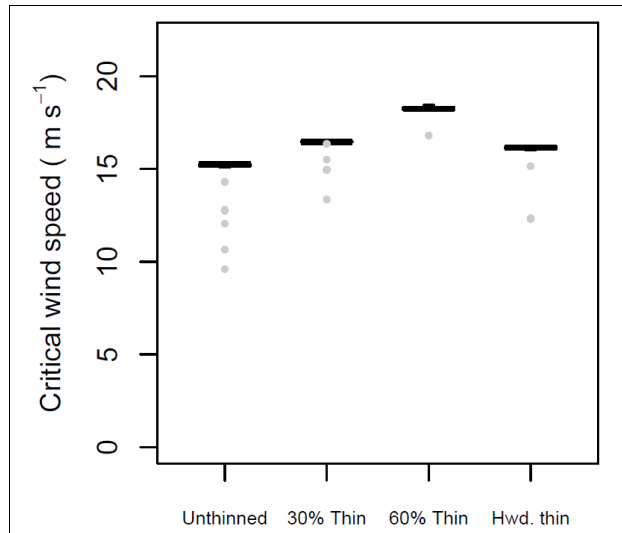
FIGURE 8 | Mean, 25 and 75% percentiles, 1.5 × interquartile range (whiskers), and outliers of critical wind speed (CWS) in m s − 1 , for intact forest and three silvicultural treatments. A 30% thin removed smallest trees up to 30% of basal area. A 60% thin removed smallest trees up to 605 of basal area. Parameters constant across figure: Profile family = Ancelin; stand orientation = A; alpha = 3.0 or LAI = 3.5; + indirect damage; + neighbor